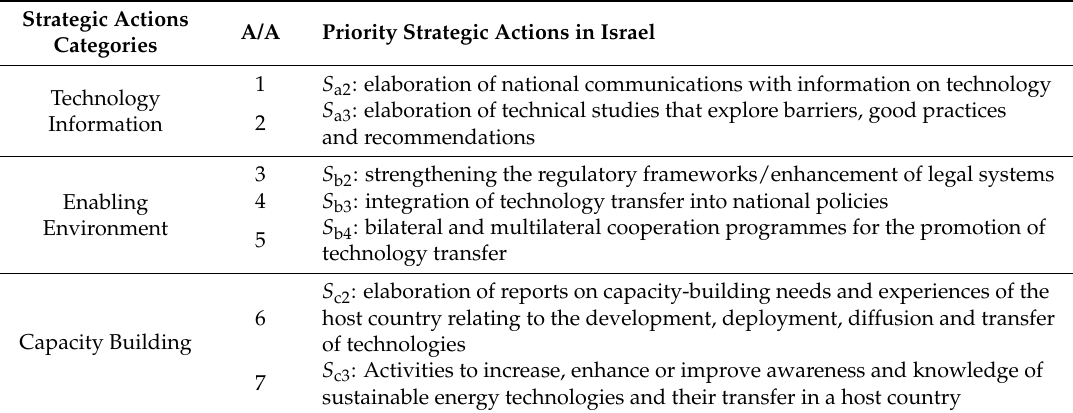
Table 5. Priority strategic actions for the promotion of technology transfer in Israel.